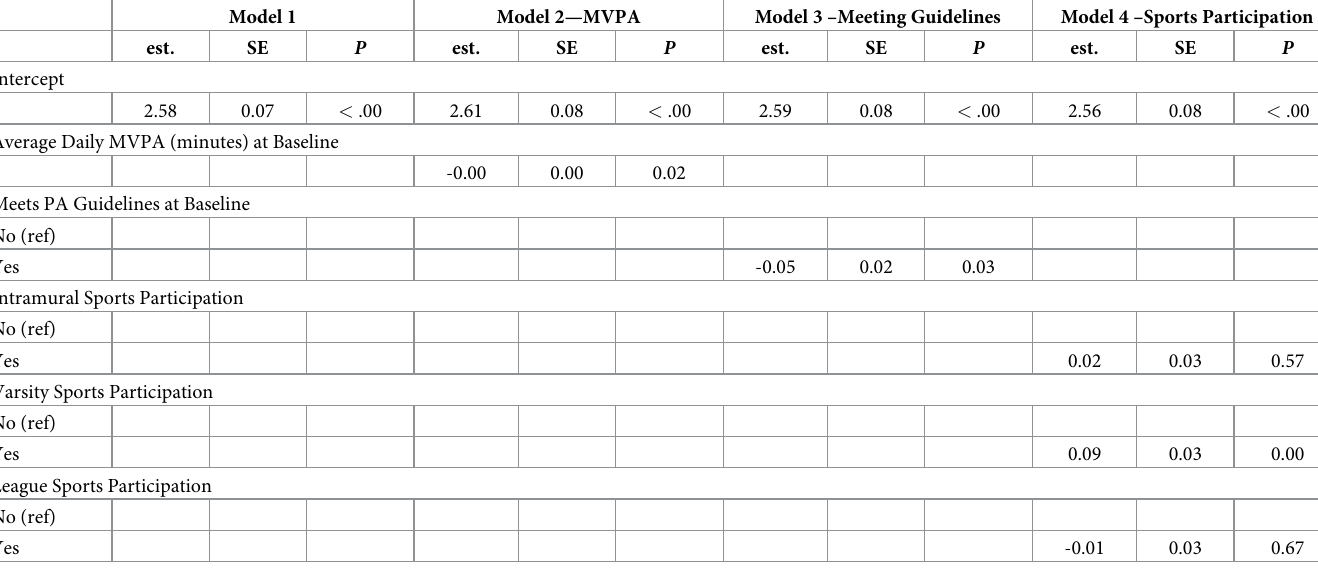
Table 4. Effect sizes for the relationship between physical activity predictors and academic outcomes: Ontario and Alberta, Canada (2013-2014/2015-2016).